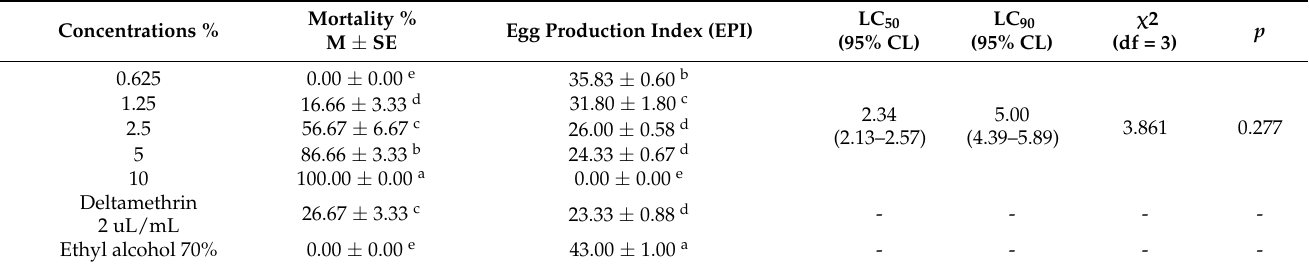
Table 3. Adulticidal and lethal concentrations (LC 50 , LC 90 ) of Lavandula stoechas against R. annulatus adult ticks.